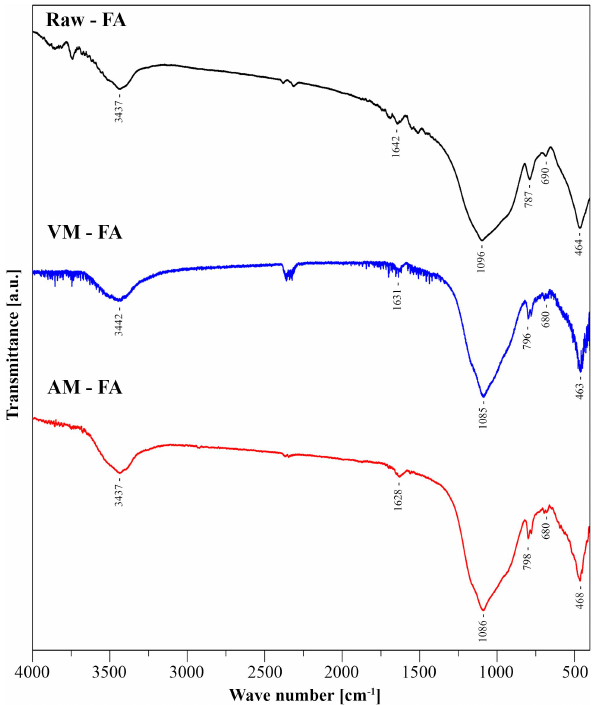
Figure 4: FTIR spectres of the raw, vibration and attrition milled fly